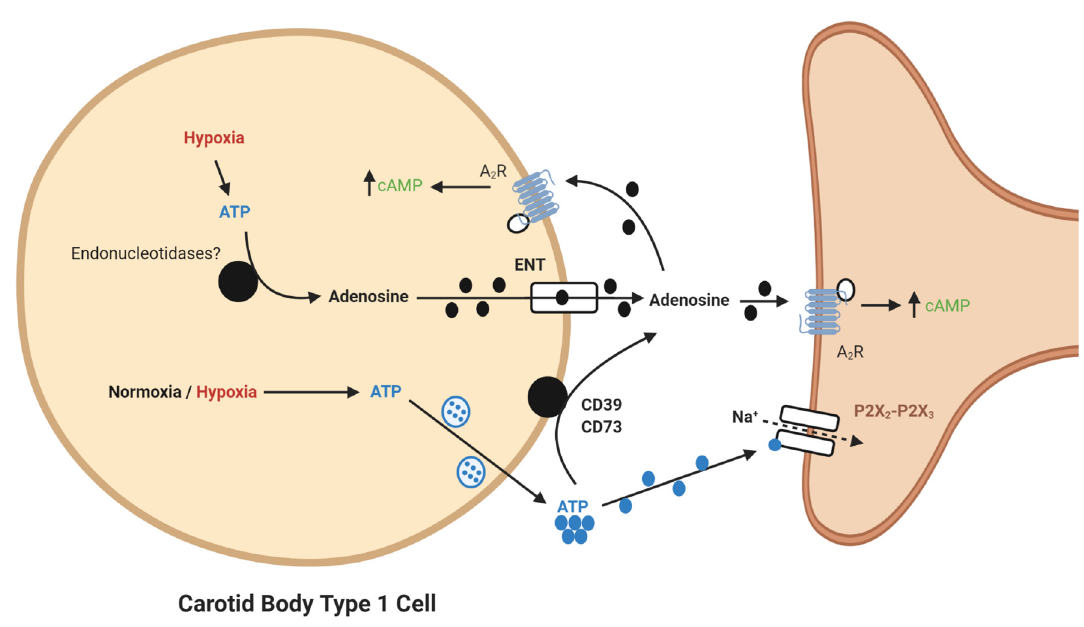
Figure 1. Schematic illustration of ecto-5 ′ -nucleotidase (CD73)-mediated adenosine generation and signaling in the carotid body (CB). During normoxia/hypoxia, ATP released as a neurotransmitter can be converted to adenosine by the action of ecto-nucleosidetriphosphate diphosphohydrolase (CD39) and CD73. Alternatively, ATP can be converted to adenosine in the type I cell and released via the equilibrative nucleoside transporter (ENT). Adenosine binds to A 2 -receptors on the pre- and post-synaptic membrane to increase baseline activity and overall hypoxic sensitivity. Filled lines denote purinergic signaling, dashed lines denote ion flow.